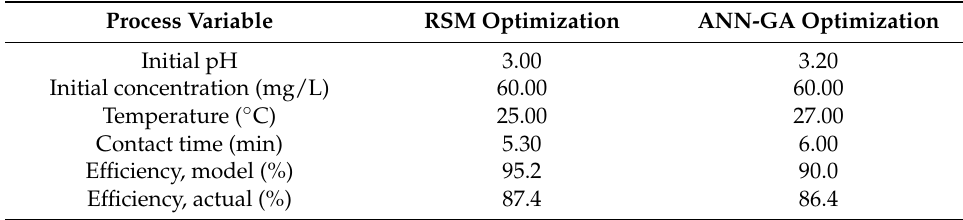
Table 4. Comparison of the optimal process conditions and optimum removal efficiency for Rh B by response surface methodology (RSM) and artificial neural network hybridized with genetic algorithm (ANN-GA)